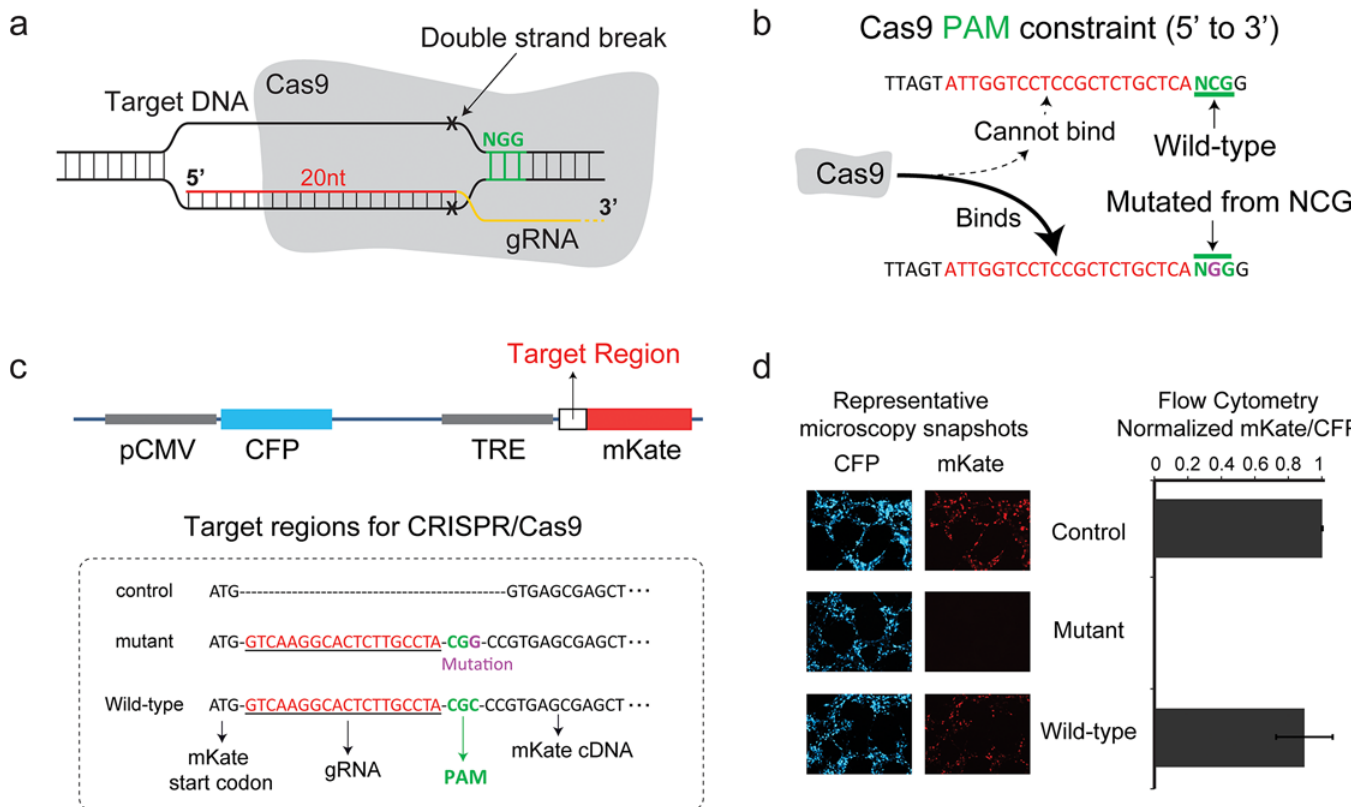
Fig 1. Protospacer Adjacent Mutated Motif-mediated targeting. (a) The gRNA-Cas9 complex targets DNA through complementarity with the gRNA sequence. Red color is the DNA binding domain. Green color is the PAM. (b) Example of the PAM constraint function for a random target sequence. (c) Schematic illustration of the fluorescence reporter plasmid. The variable regions, which correspond to either KRAS wild-type or p.G13A mutant alleles, were shown in the box and cloned after the mKate start codon. (d) Flow cytometry and fluorescence microcopy results for the normalized mKate expression. Both assays demonstrated that CRISPR specifically silenced the mKate carrying the KRAS p.G13A mutant